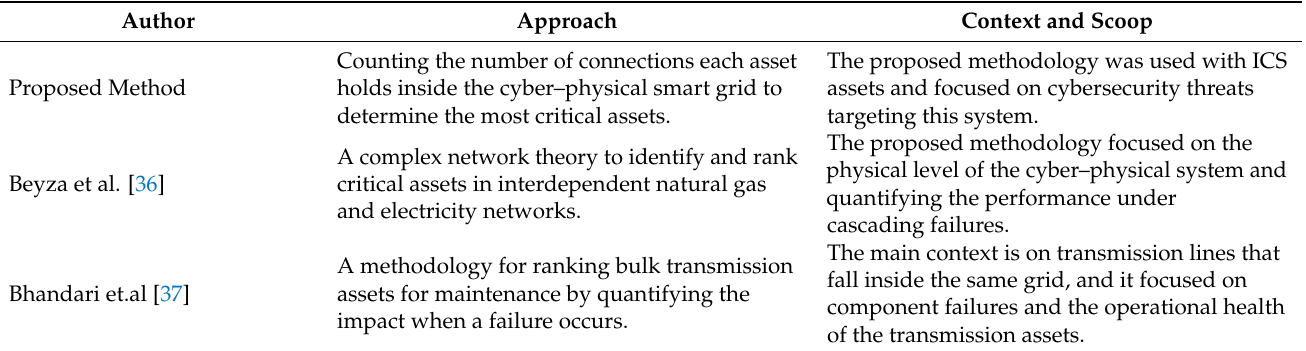
Table 4. Comparison between the proposed method and related methods for ranking critical